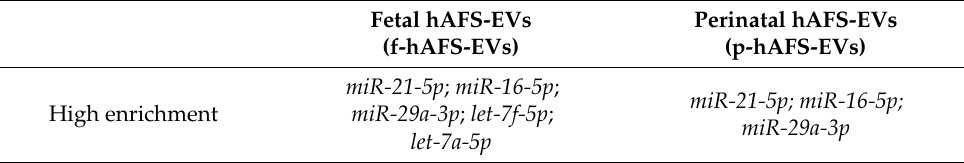
Figure 8. RNA cargo profiling of fetal- and perinatal hAFS-EVs. ( A ) Relative percentage distribution of RNA types detected within fetal- vs perinatal hAFS-EVs (f-hAFS-EVs and p-hAFS-EVs, respectively). Slice of pie chart referring to average percentage of RNA amount in f-hAFS-EVs (left panel) and p-hAFS-EVs (right panel) of n = 3 experiments. ( B ) Upset plot of miRNAs enriched in hAFS-EVs according to gestational stage and cell preconditioning. ( C ) The 15 most enriched miRNAs within f-hAFS-EVs normo (64.47 ± 0.28%), f-hAFS-EVs hypo (63.84 ± 0.43%); p-hAFS-EVs normo (64.08 ± 0.92%) and p-hAFS-EVs hypo (65.78 ± 2.82%); values are expressed as mean percentage ± s.e.m of n = 3 experiments. Table 2. miRNA core as steadily expressed in the fetal- and perinatal